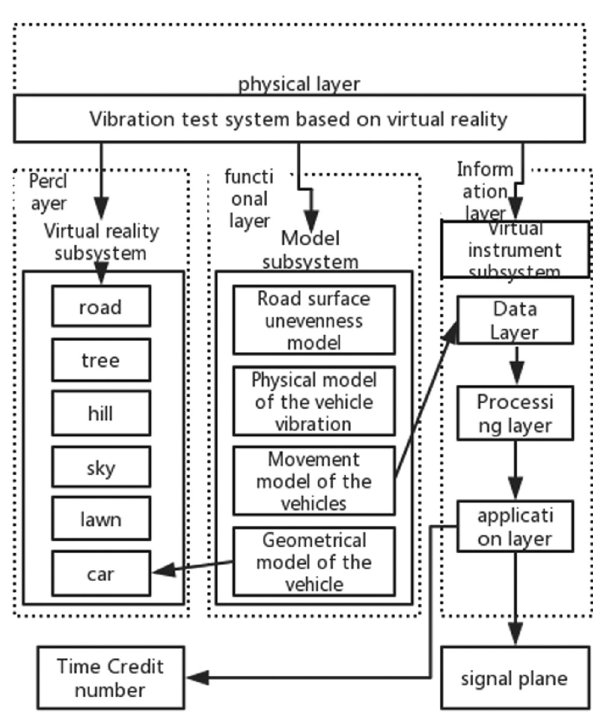
Figure 2: Frame design of vehicle vibration virtual test system based on